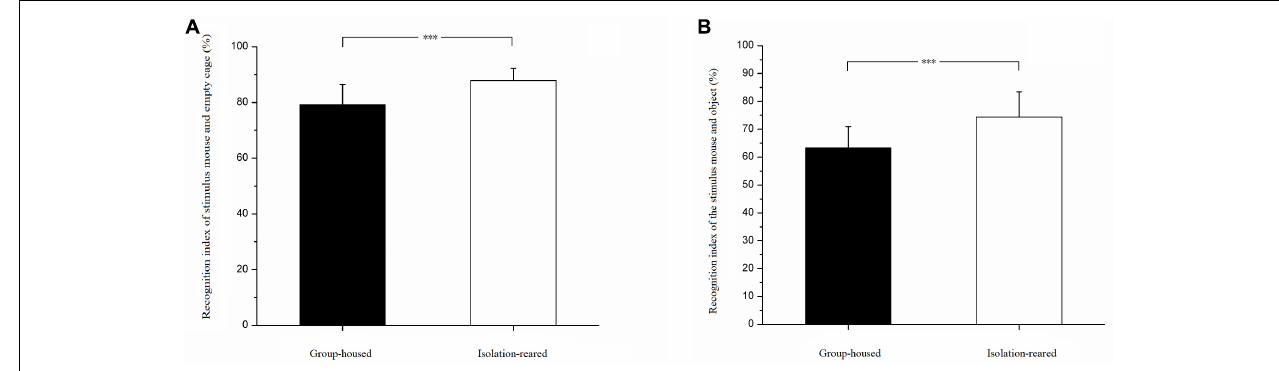
FIGURE 1 | Results of social affiliation test. (A) Recognition indexes of stimulus mouse and empty cage. (B) Recognition indexes of stimulus mouse and object. ∗∗∗ indicate p < 0.001. Bar represent mean. Error bar represent standard deviation (SD).